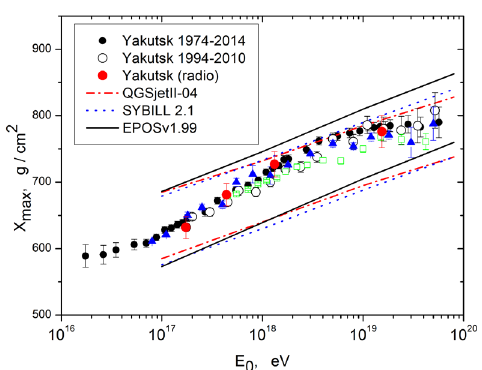
Figure 2. The dependence of X max on energy, obtained from ob- servations of Cherenkov radiation for the period 1974-2014. and 1994-2010, at the Yakutsk array of the EAS. Comparison with X max received on the radio extension with model